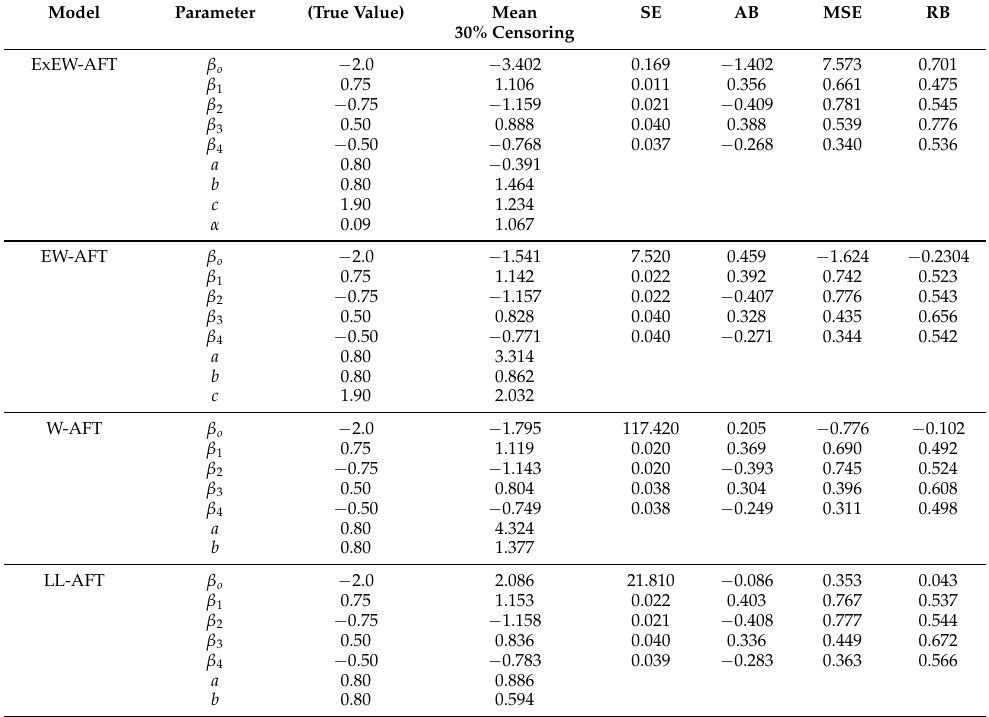
Table 8. Simulation study for scenario 2 ( n = 5000) with about 30% censored observations is used to compare model